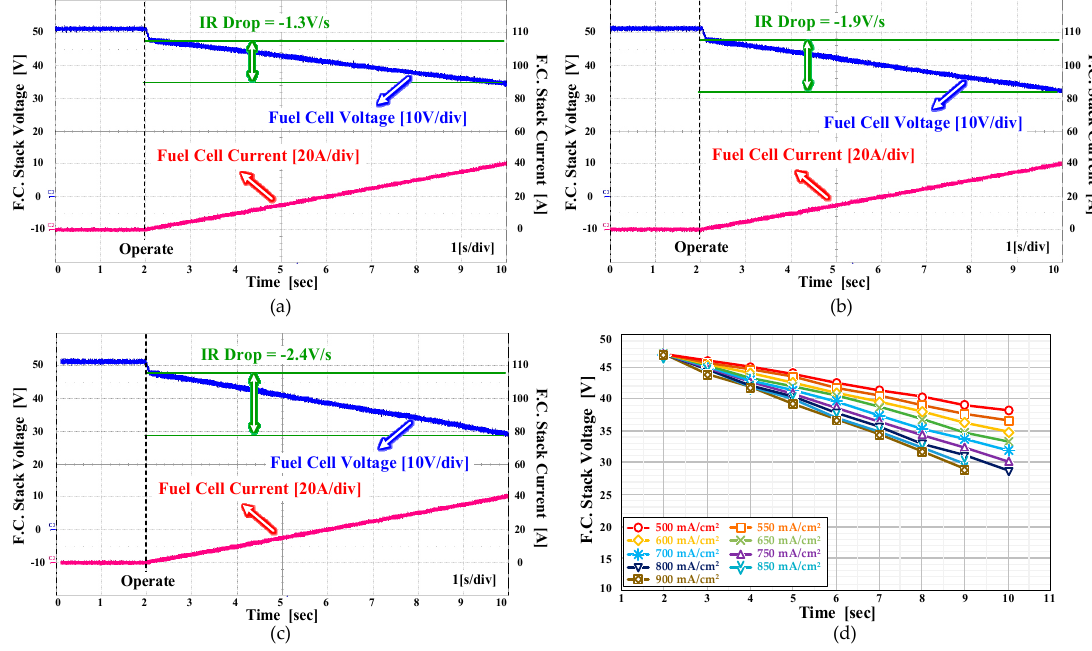
Figure 13. Fuel cell waveforms for current density of the ( a ) 500 mA/cm 2 , ( b ) 700 mA/cm 2 , ( c ) 900 mA/cm 2 , and ( d ) voltage drop curve depending on current density of platinum catalyst.